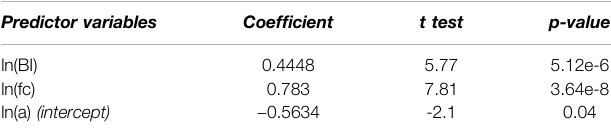
TABLE 4 | Regression results for each predictor